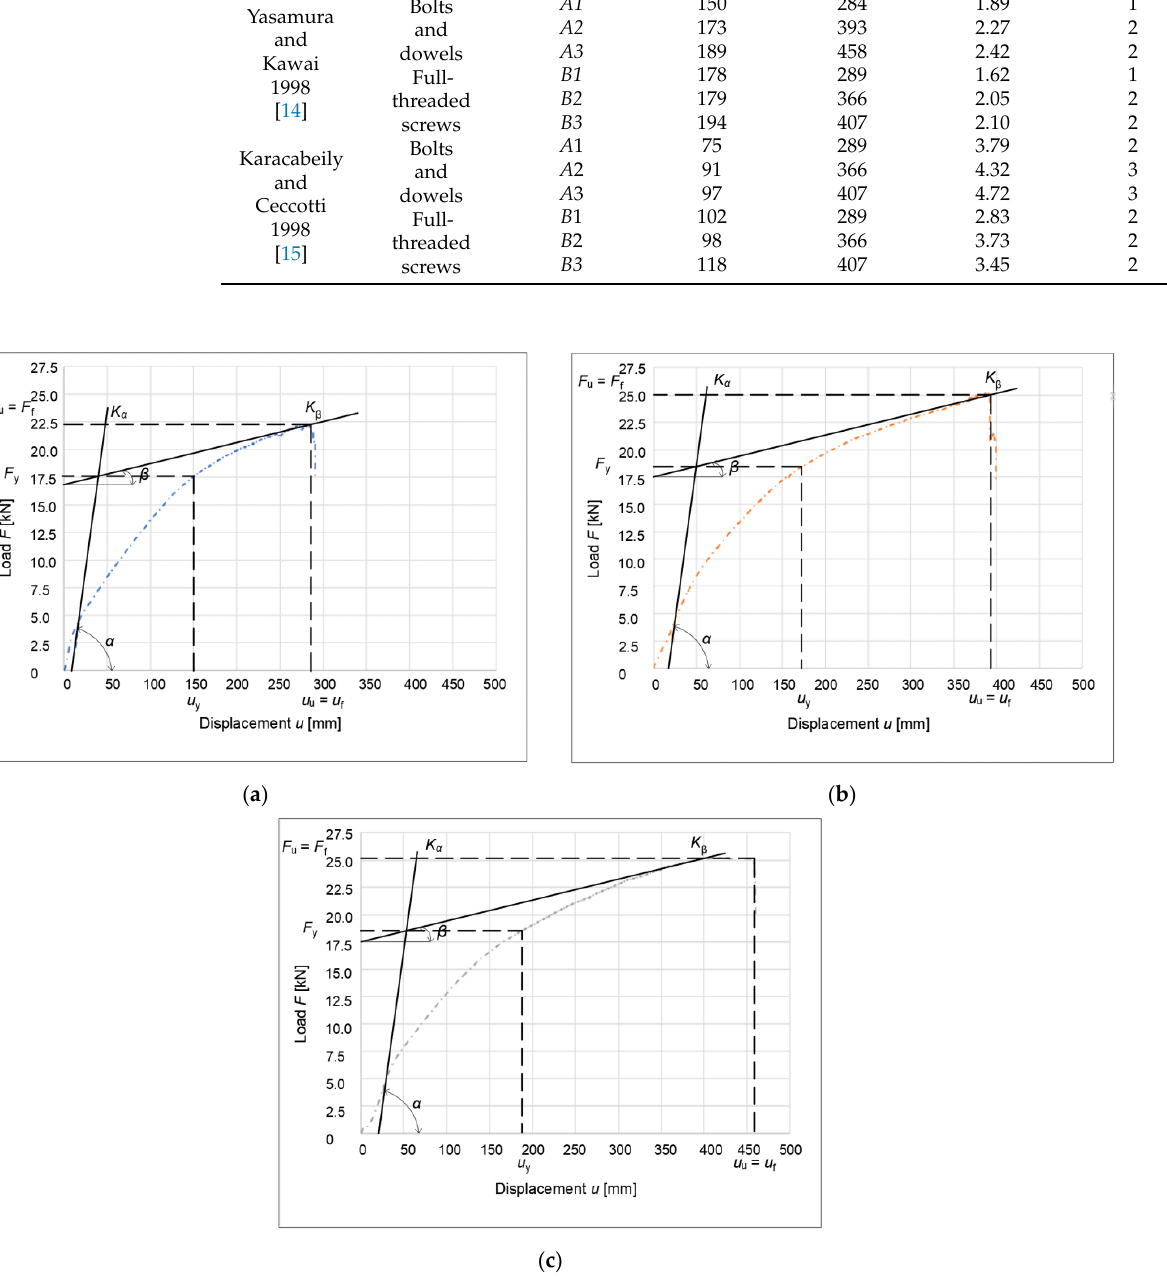
Figure 19. Graphical representation of the yield strength of a connection formed from bolts and dowels according to Yasamura and Kawai (1998): ( a ) unreinforced specimen; ( b ) reinforced partitions; and ( c ) reinforced rung and struts (stands).